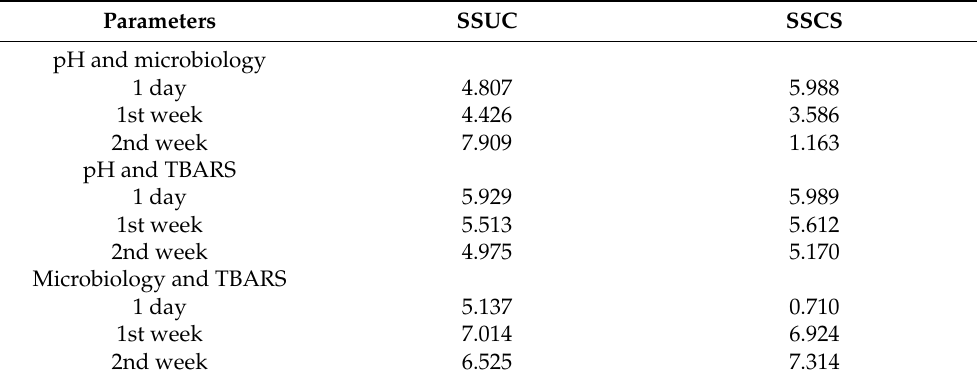
Table 7. Intercept among the Longissimus dorsi muscle’s pH, microbiology, and oxidative stability (TBARS value) in Korean Hanwoo Finishing